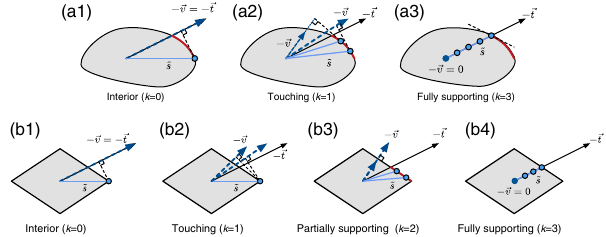
FIG. 4. Determining the anchor points of the Gaussian distrib- uted vector ð ⃗ t; t 0 Þ onto the convex hull of the manifold, denoted as ˜ s ð ⃗ t; t 0 Þ . Here, we show, for the same vector ⃗ t , the change in ˜ s ð ⃗ t; t ∞ to −∞ . (a) D ¼ 2 strictly convex 0 Þ as t 0 decreases from þ manifold. For sufficiently positive t 0 , the vector − ⃗ t obeys the constraint g ð ⃗ t Þ þ t 0 > κ ; hence, − ⃗ t ¼ − ⃗ v , and the configuration corresponds to an interior manifold (support dimension k ¼ 0 ). violates the above constraints, and ˜ s is a point on the boundary of the manifold that maximizes the projection on the manifold of a vector ð − ⃗ v; − v 0 Þ that is the closest to ð − ⃗ t; − t 0 Þ and obeys ˜ s is a point in the interior of the manifold in the direction of − ⃗ t (fully supporting with k ¼ 3 ). (b) D ¼ 2 square manifold. Here, in both the interior and touching regimes, ˜ s is a vertex of the square. In the fully supporting regime, the anchor point is in the interior and collinear to − ⃗ t . There is also a partially supporting regime when − t 0 is slightly below t . In this regime, − ⃗ v is fs perpendicular to one of the edges and ˜ s resides on an edge, corresponding to manifolds whose intersections with the margin planes are edges ( k ¼ 2